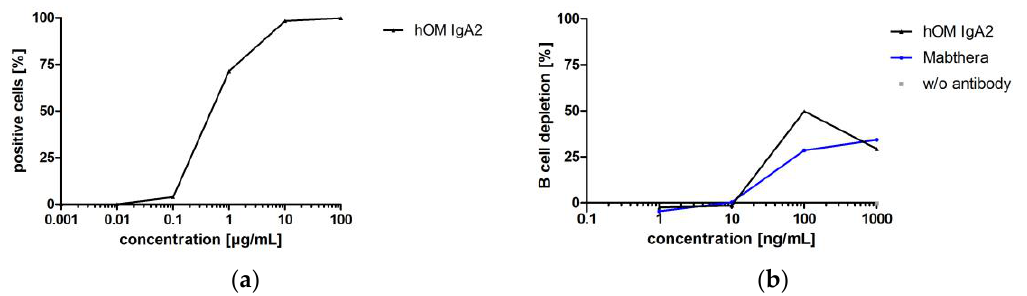
Figure 9. hOM anti-CD20 IgA2 antibody binds Raji target cells and mediates B cell depletion. ( a ) Concentration-dependent binding of hOM IgA2 to Raji target cells by flow cytometry. ( b ) Whole blood was used as a source for target and effector cells. Mean values of duplicates and one out of two independent experiments are shown. hOM IgA2 showed at least comparable maximal B cell depletion like commercially available Mabthera anti-CD20 IgG control.